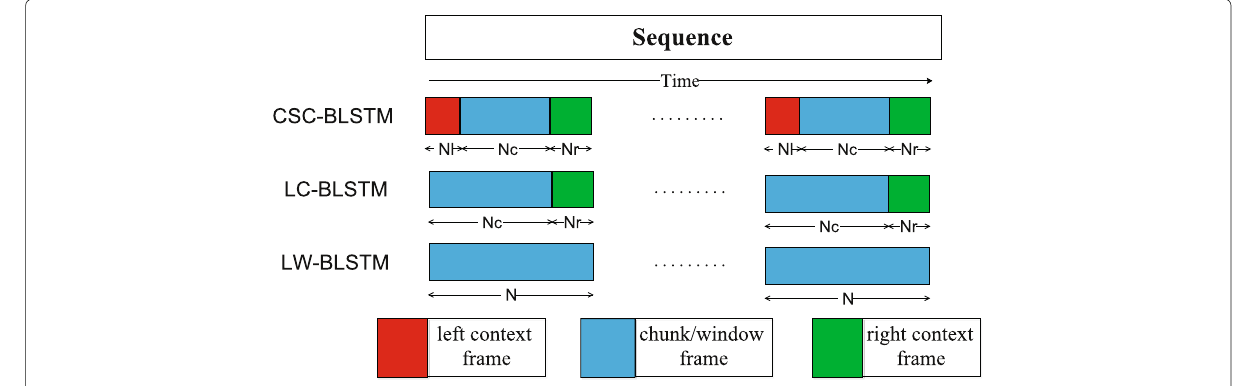
Fig. 2 Illustration of local window BLSTM